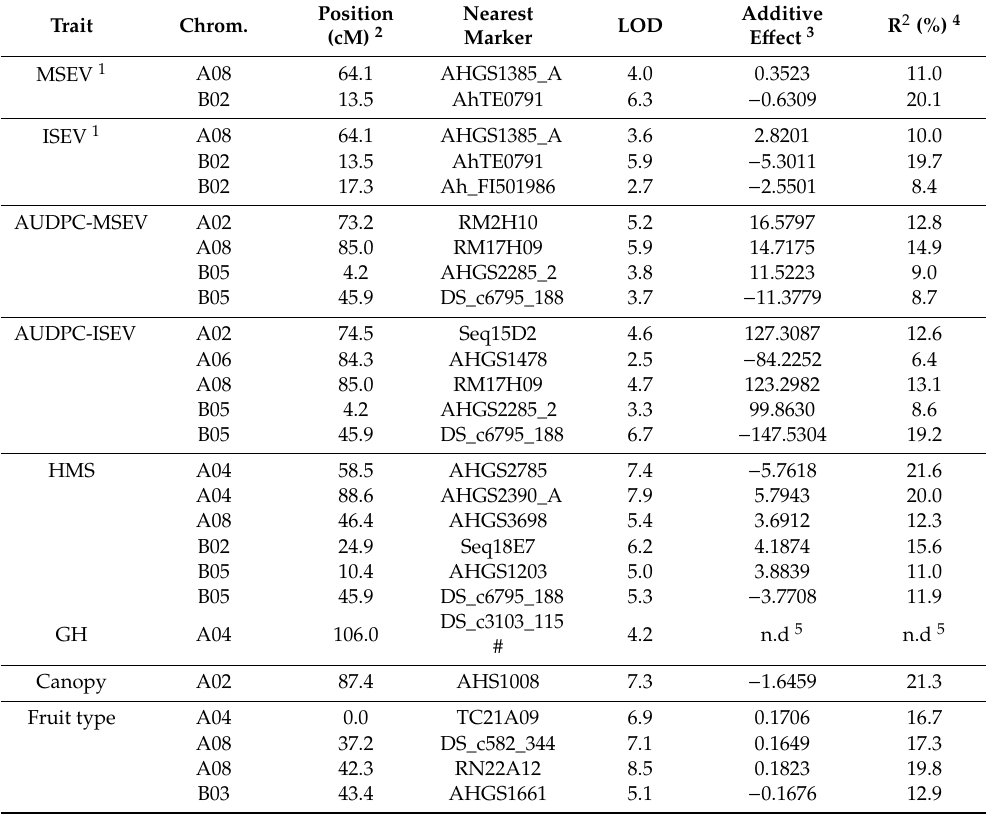
Table 3. QTLs identified for leaf spots resistance (MSEV, ISEV, AUDPC-MSEV, AUDPC-ISEV) 1 , height of the main stem (HMS), growth habit (GH), canopy, and fruit